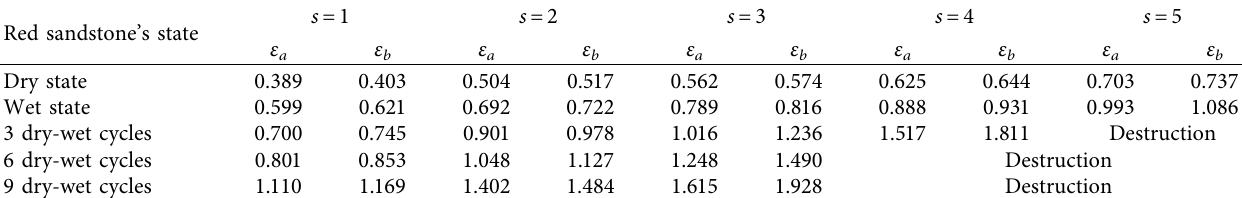
Table 4: Axial strain changes of the red sandstone’s creep (unit: 10 − 2 ).